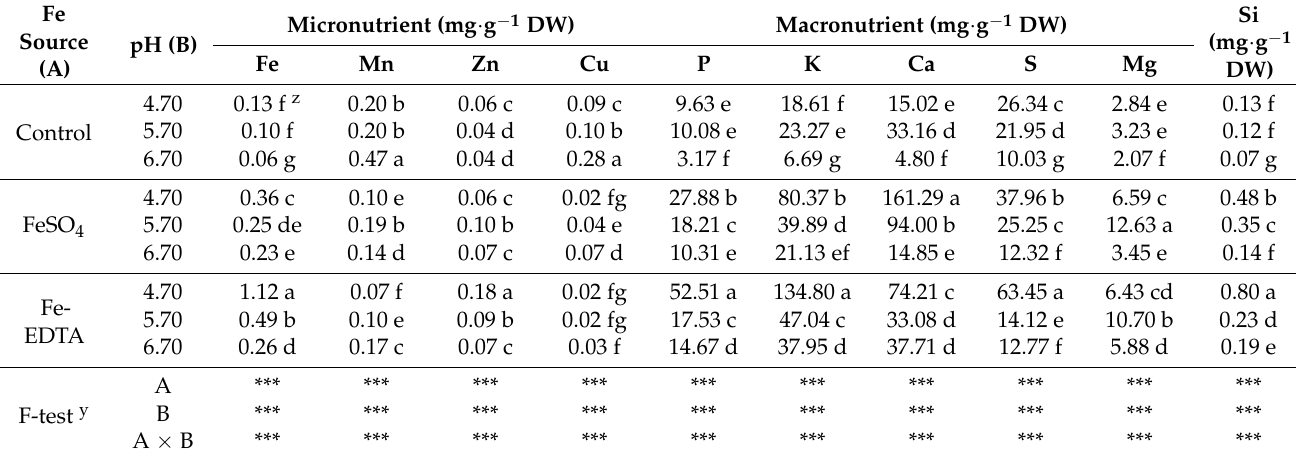
Table 6. Mineral contents in H. macrophylla after 60 days of culture.